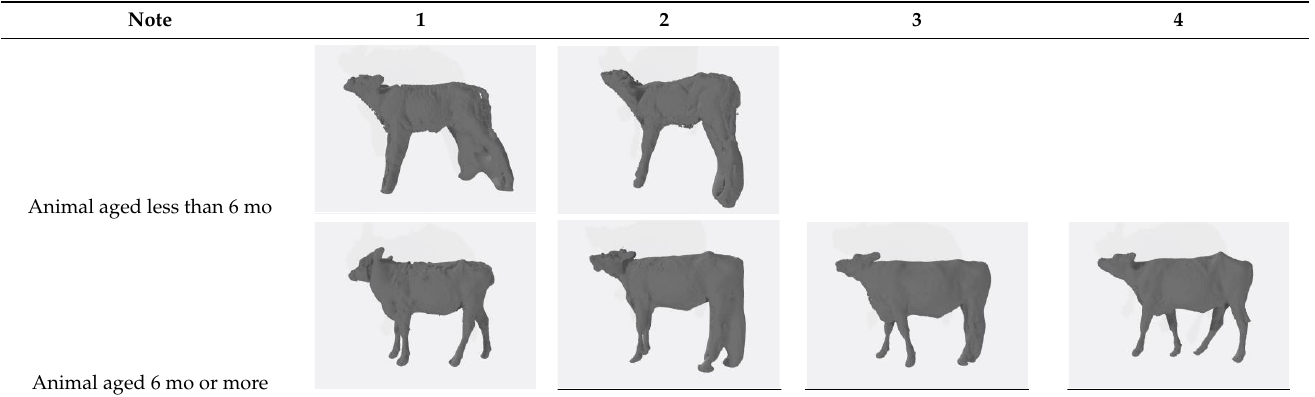
Table 2. Scoring scale from 1 – 4 (1: not used; 2: partially usable; 3: some defects; 4: sufficient) of 3D images, according to the age of heifers.